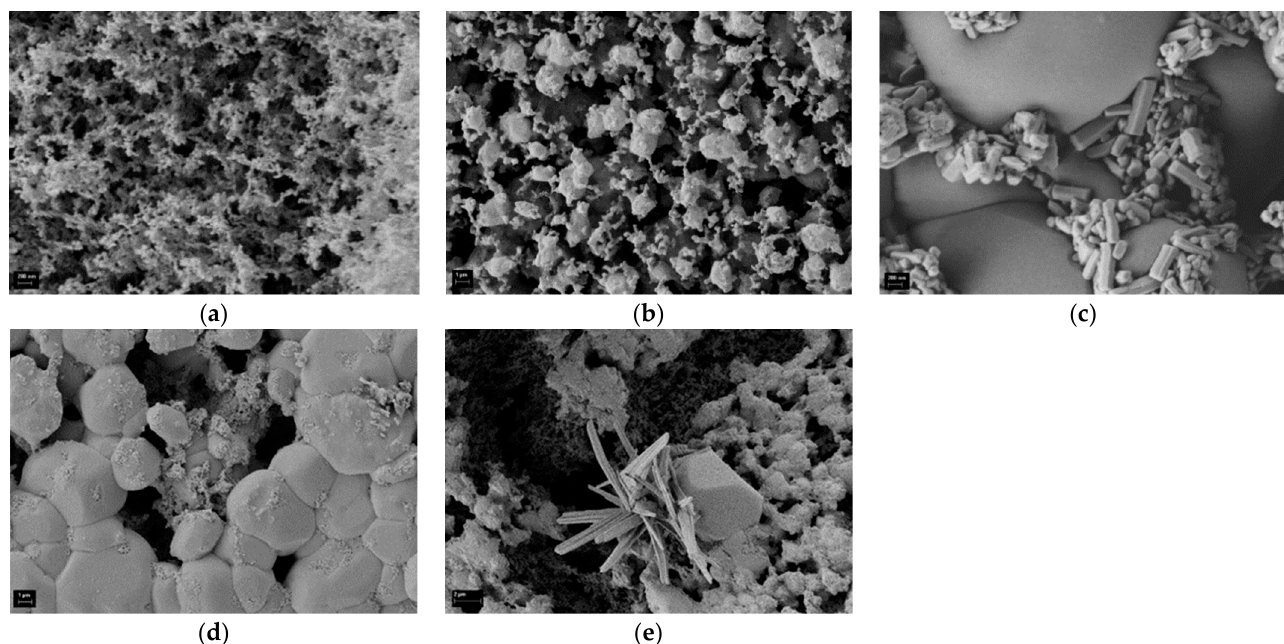
Figure 8. SEM images of TPM samples ( a ) WP; ( b ) 50CCP; ( c ) CCP; ( d ) CCP1KAO; ( e ) CCP2KAO. Table 5 . Composition of TMP samples as determined by EDS (for fuel names see Table 2). (norm, wt.